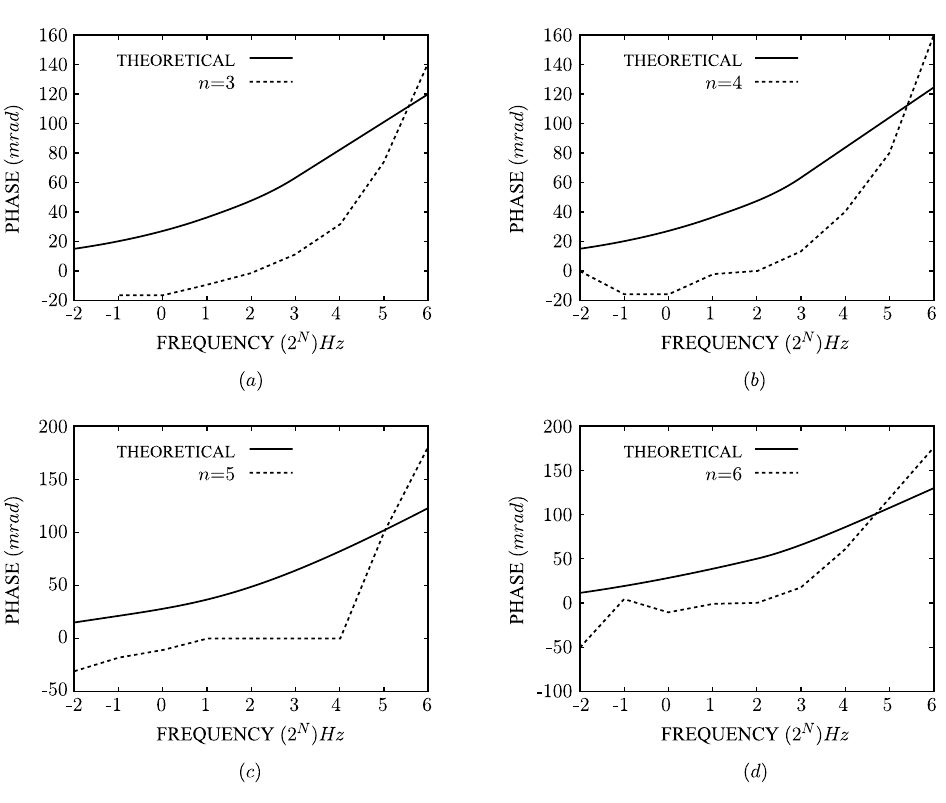
Fig. 10 – Fit between the theoretical and experimental phase data, obtained by inversion of Dias’ parameters employing L2 Norm, at the sea bottom: n = array spacing (a) n=3; (b) n=4; (c) n=5; (d) n=6.